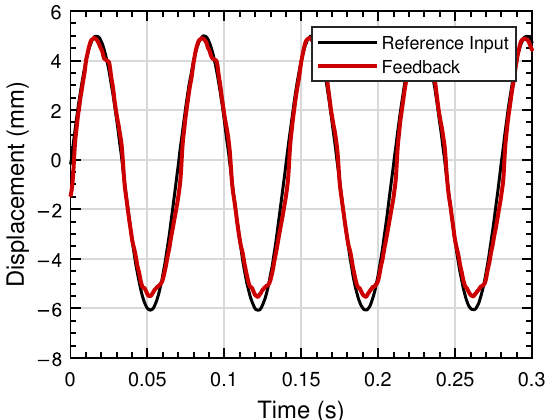
Figure 10. The commanded position and feedback of the actuator while